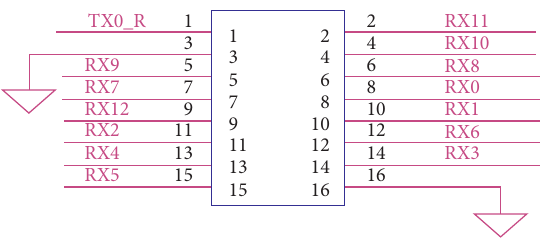
Figure 13: Connector layout of